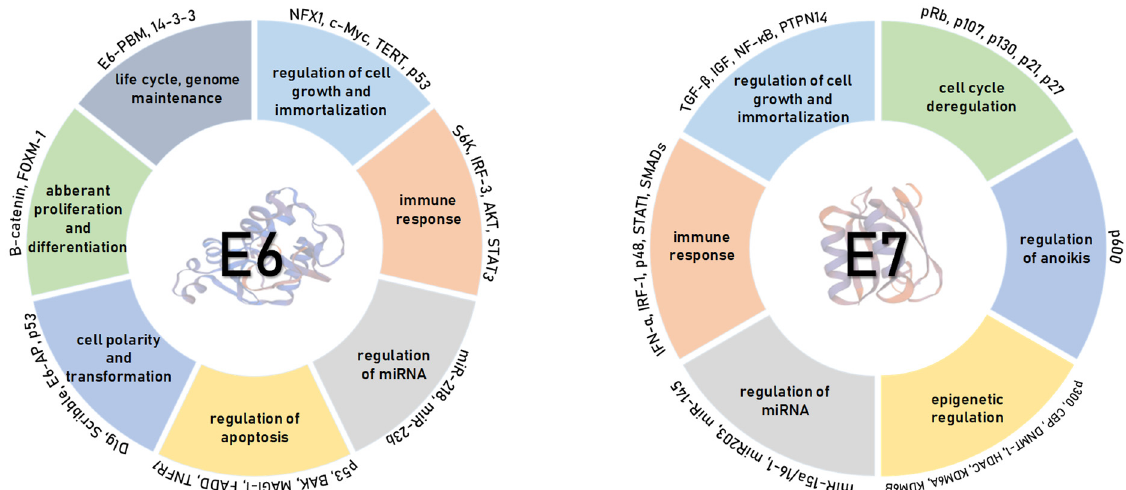
Figure 4. HPV E6 and E7 employ a multifaceted approach in modulating cell behaviour. The oncoproteins utilize various strategies and interact with numerous host cellular proteins to modulate various cellular processes important for productive viral life cycle and malignant progression. By the joint actions of E6 and E7, HPV can evade the host immune response and establish a persistent infection and to deregulate programmed cell death pathways, such as apoptosis and anoikis, in order to make the cells more tolerant to the changes in cell polarity and uncontrolled proliferation, which inevitably leads to cell transformation and immortalisation. Concomitantly, E6 and E7 regulate differential expression of micro RNAs in HPV-infected keratinocytes or HPV-induced malignancies. Likewise, the epigenetic signatures of various genes have been found to differentiate between lesions and normal tissue due to the interactions of oncoproteins with methyl- and